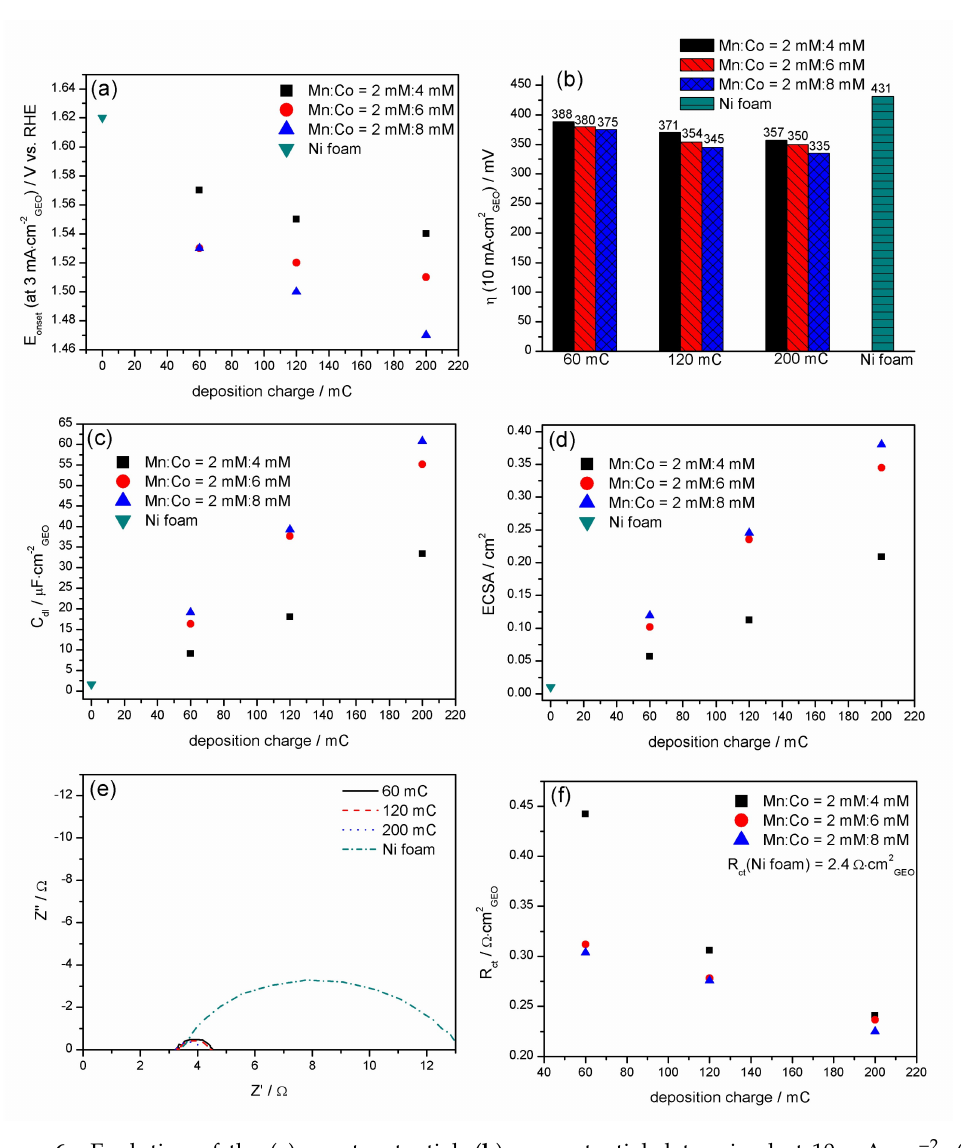
Figure 6. Evolution of the ( a ) onset potential, ( b ) overpotential determined at 10 mA · cm − 2 , ( c ) double-layer capacitance, ( d ) electroactive surface area (ECSA), ( e ) electrochemical impedance spectra (EIS) measured at 0.7 V vs. Ag / AgCl, and ( f ) R ct of the oxygen evolution reaction (OER) as a function